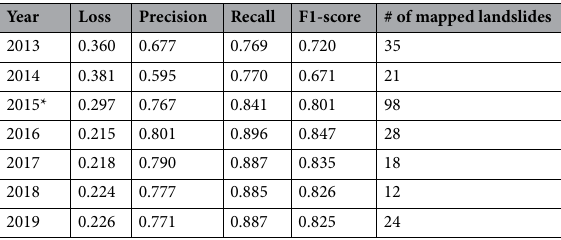
Table 1. Accuracy of mapped landslides in time in Rasuwa, Nepal. * Co-seismic year.